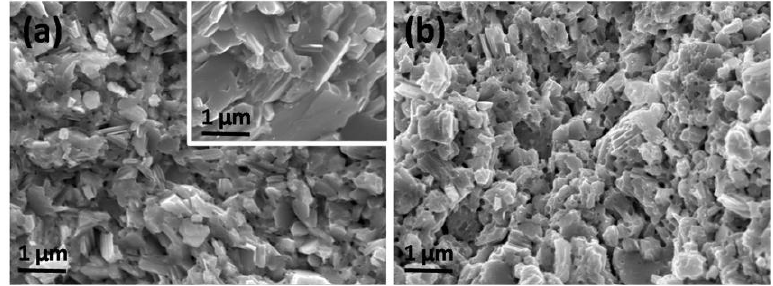
Figure 2. ( a ) and ( b ) SEM micrographs of the fresh fracture surfaces for the doped bulks SnSe-0.5wt% LaCl 3 and SnSe-1.0wt% LaCl 3 , respectively. The morphology of the sample without LaCl 3 was given inset of Figure 2a.